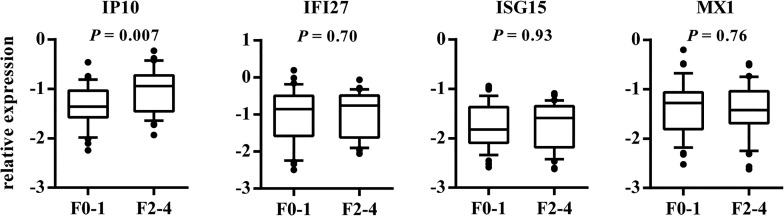
Association between the hepatic expression of IP10, IFI27, ISG15, and MX1 with F0-1 and F2-4 fibrosis.The y-axis shows the relative unit of a given gene, normalized to GAPDH in log scale, as a box plot displaying the 10th, 25th, 50th, 75th, and 90th percentiles of expression levels. Fibrosis stages are defined according to the modified Scheuer classification.